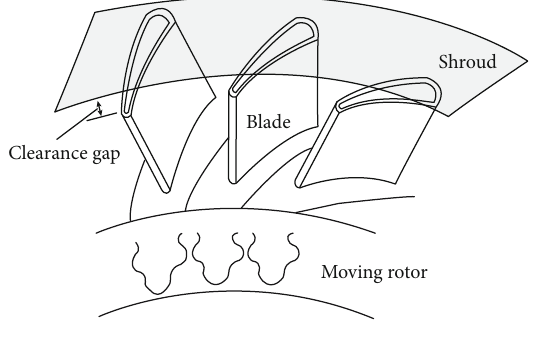
Figure 1: Schematic of a tip gap